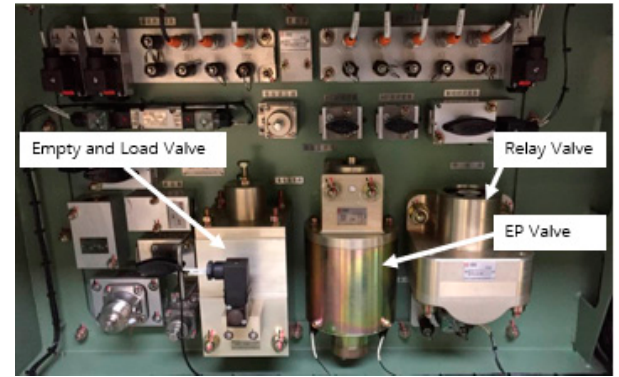
Figure 1. Standard Electric Multiple Units (EMU) Brake Control Device.